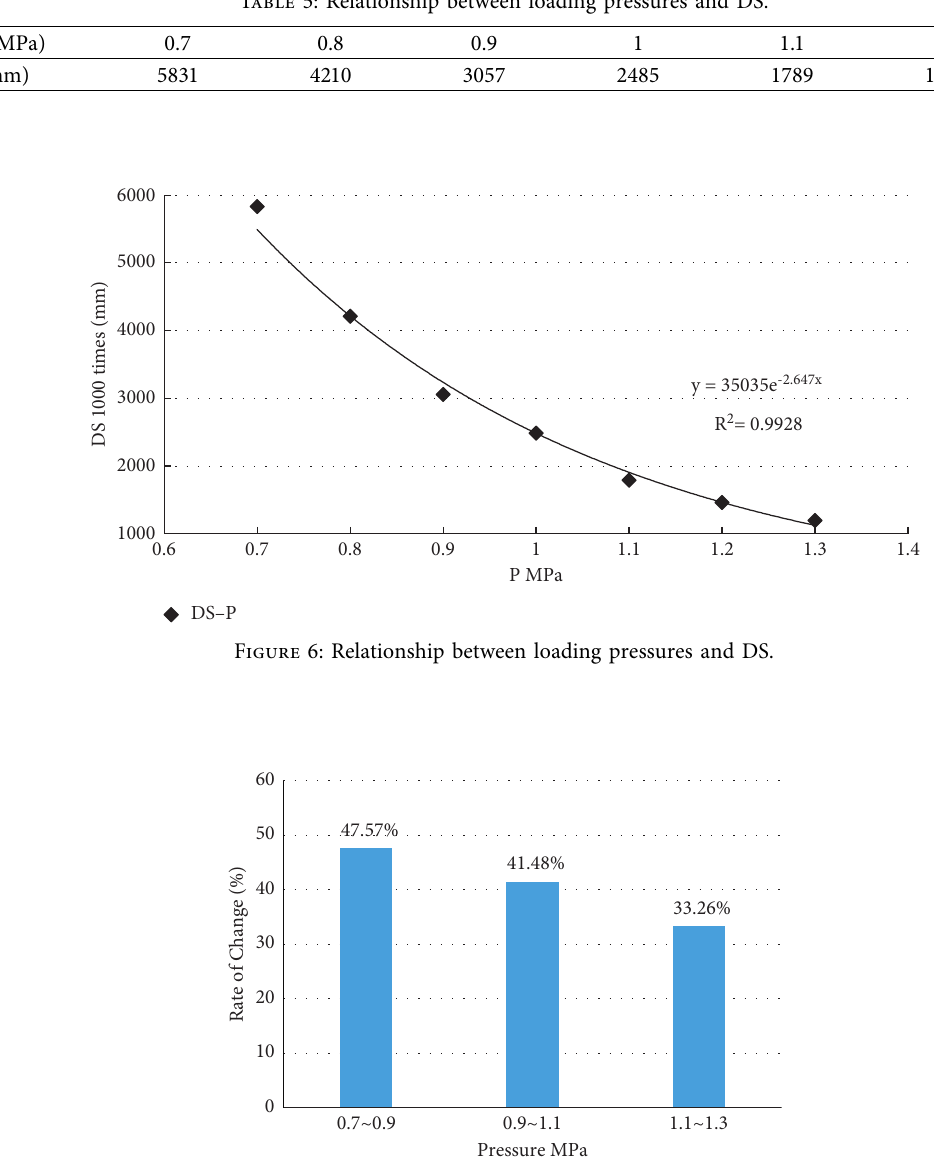
Figure 7: Percentage decrease in DS according to the increase in loading